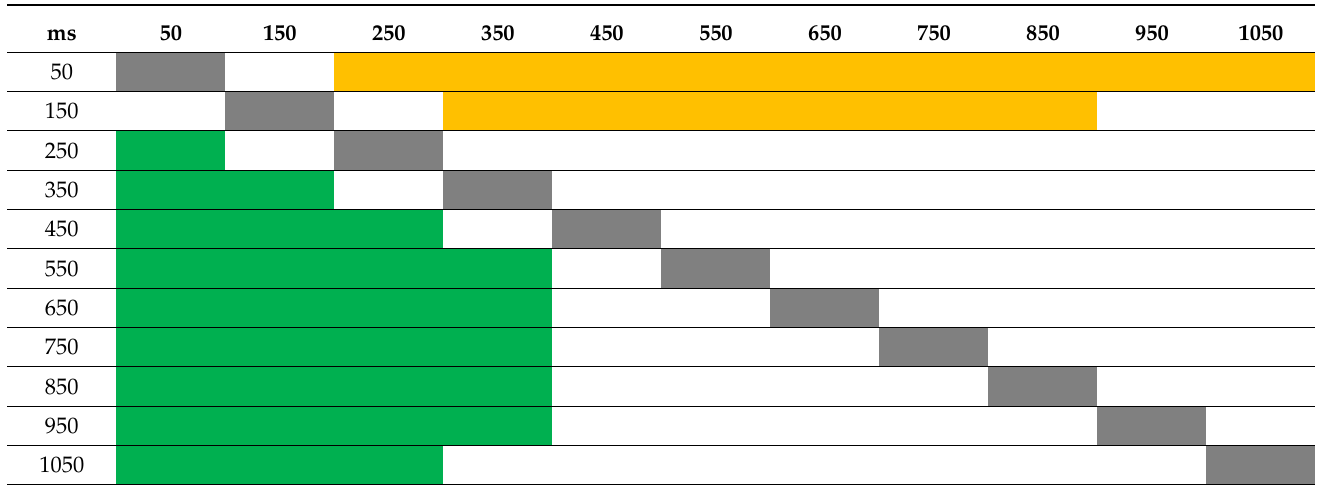
Table A1. Statistical significance between window sizes for var algorithm. Green indicates statistically significant difference ( p < 0.05; Bonferroni-corrected) for the RMSE metric, and orange indicates significant difference ( p < 0.05; Bonferroni-corrected) for the cross-correlation metric. Grey indicates diagonal fields.